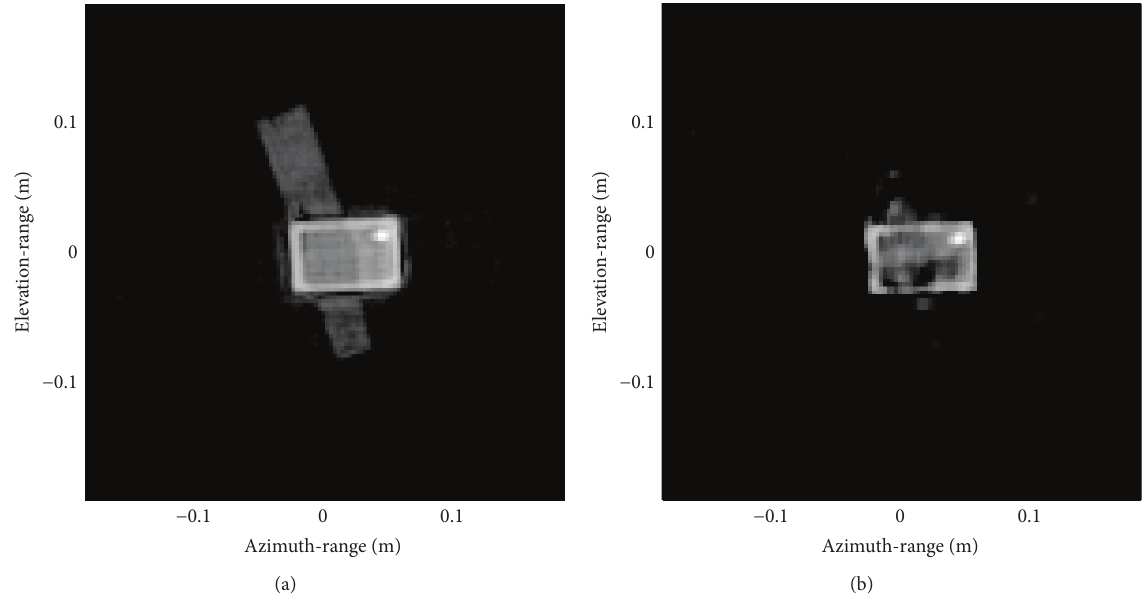
Figure 8: MMW images of the card: (a) the result of WDA using the full data and (b) the result of the CS-based method using only 25% of the full